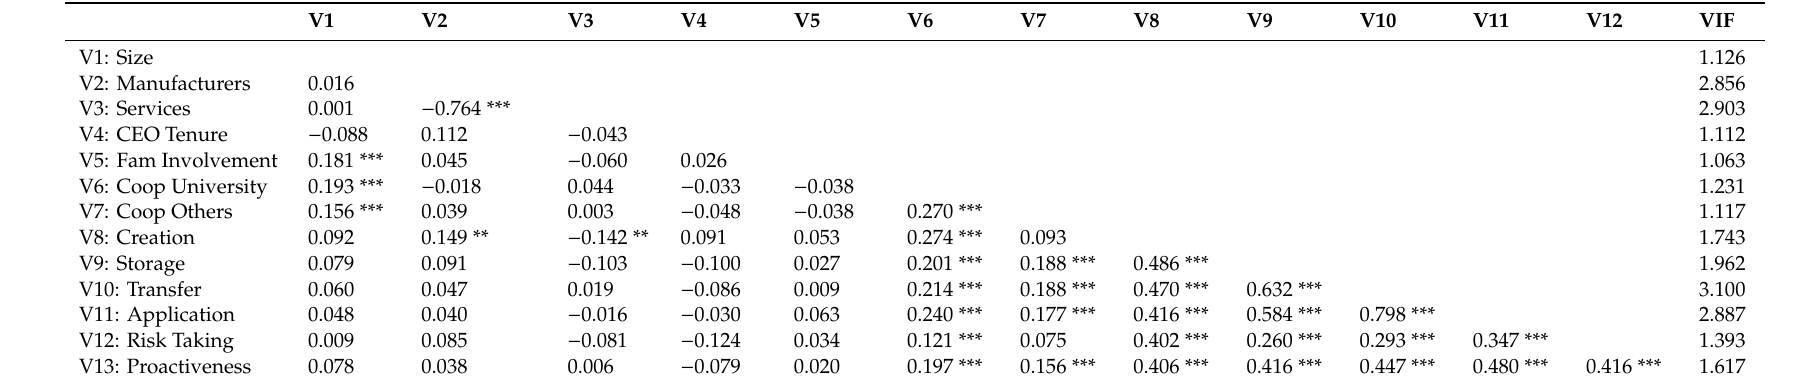
Table 1. Correlation matrix and variance inflation factors